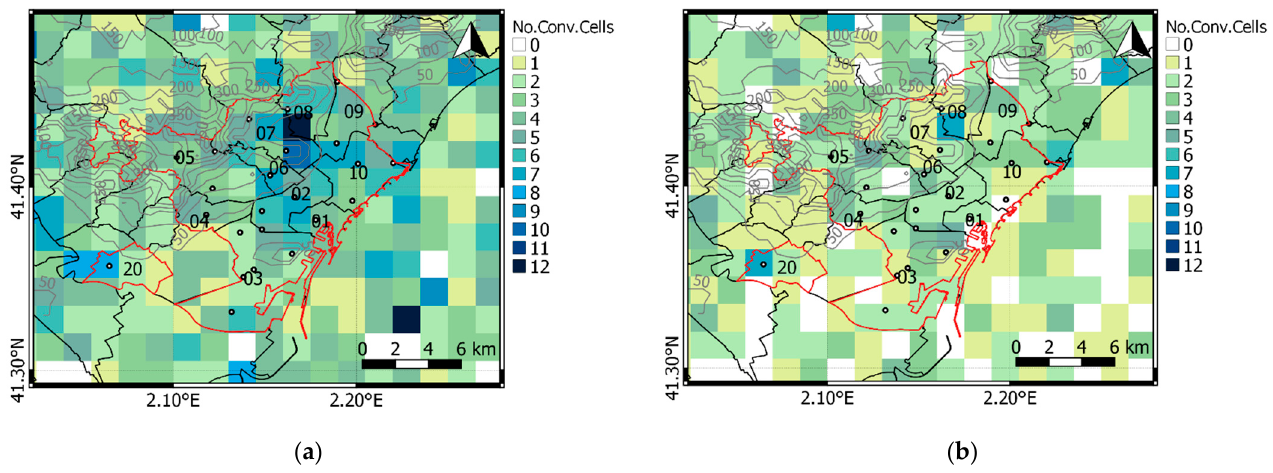
Figure 9. Distribution of storm cells centroids across all episodes with NAB 3 or 4 ( a ) and for episodes with the mentioned NAB levels and reported incidents ( b ).